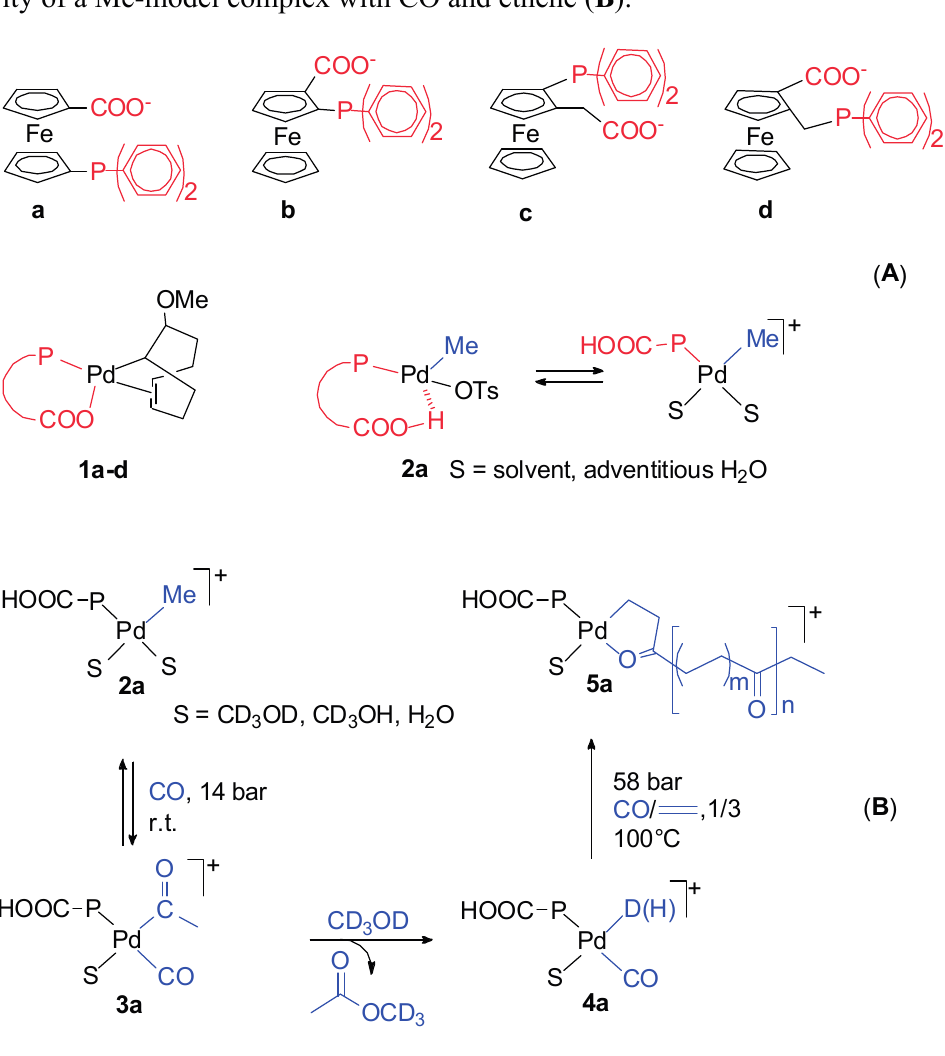
Figure 13. Fospharylferrocenecarboxylate ligands and relevant catalyst precursors ( A ); reactivity of a Me-model complex with CO and ethene ( B